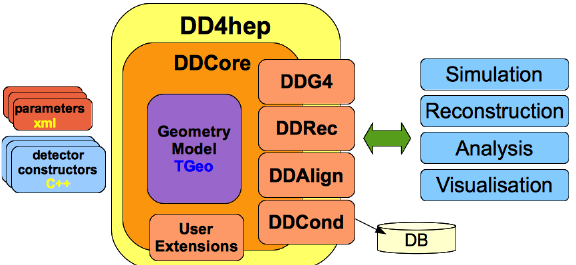
Figure 1. Schematic view of the component structure of DD4hep with the core component DDCore and optional extensions such as DDG4, DDRec, DDCond and